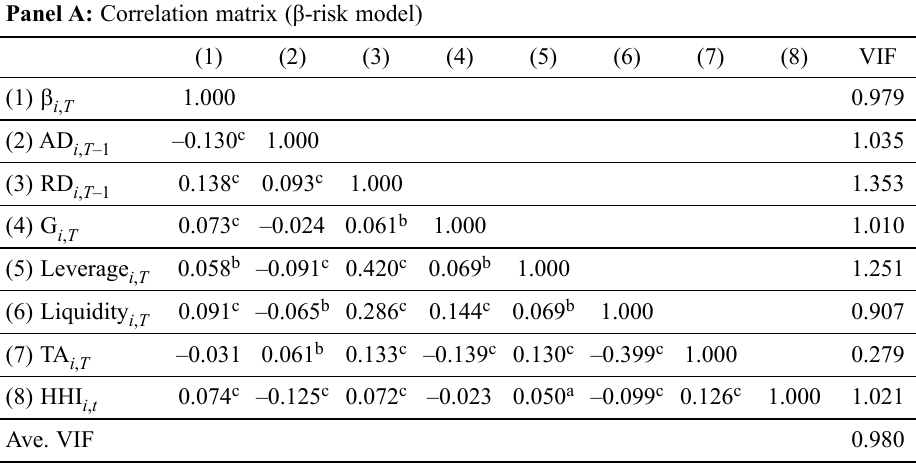
Table 2. Correlation